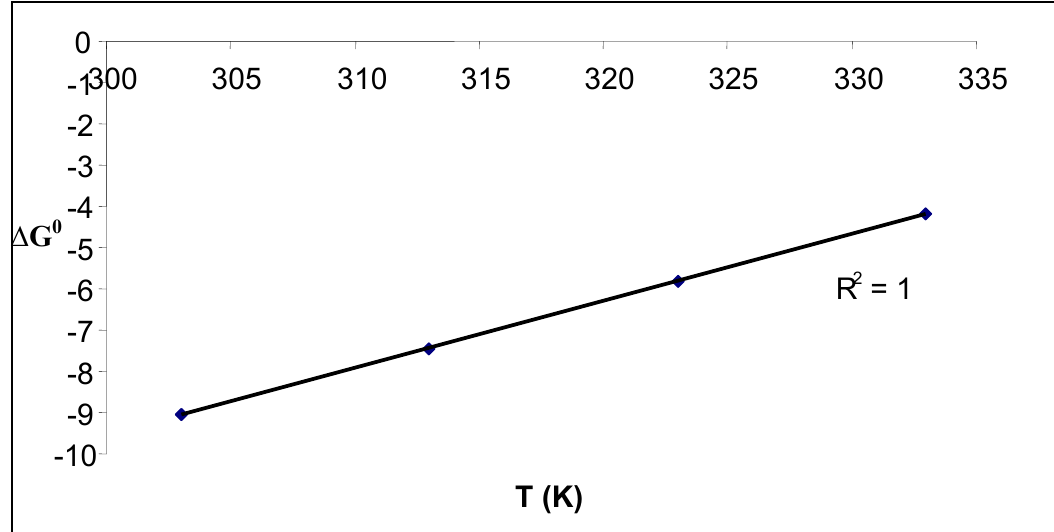
Figure 13. Plot of Gibb’s free energy change versus temperature for adsorption of fluoride onto eggshell